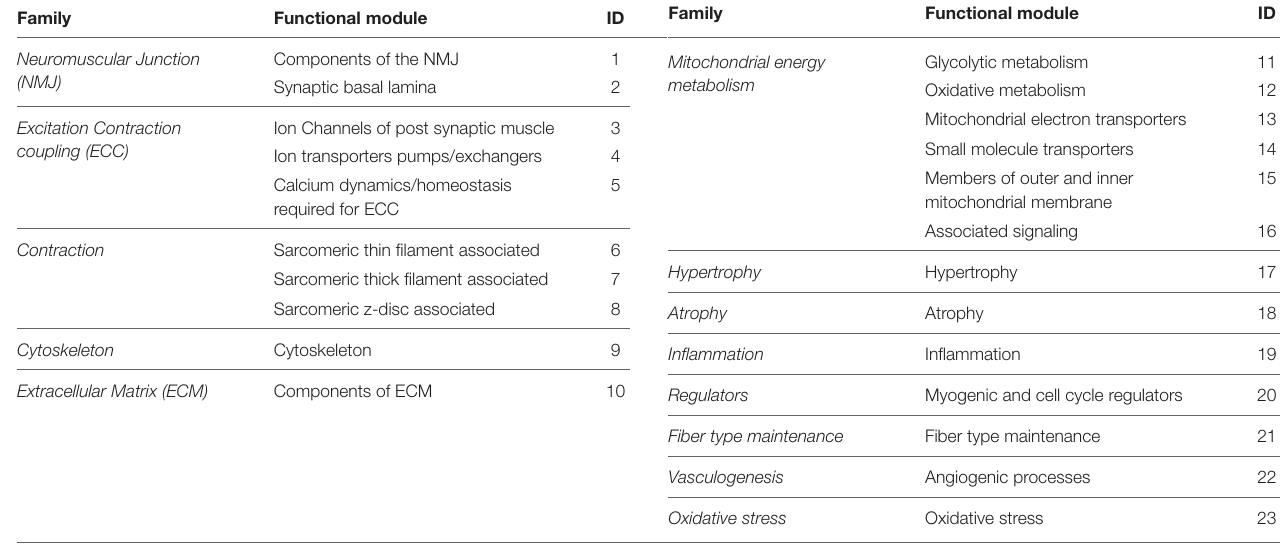
TABLE 2 | Functional modules in